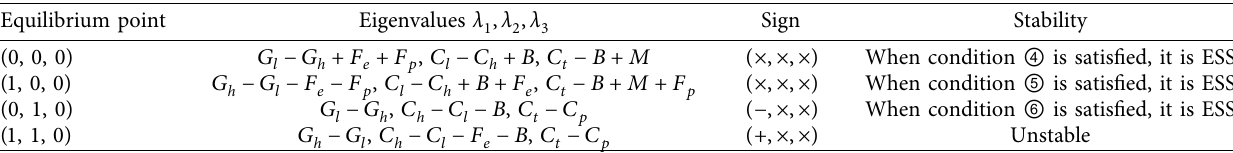
Table 4: Asymptotic stability of the equilibrium point in